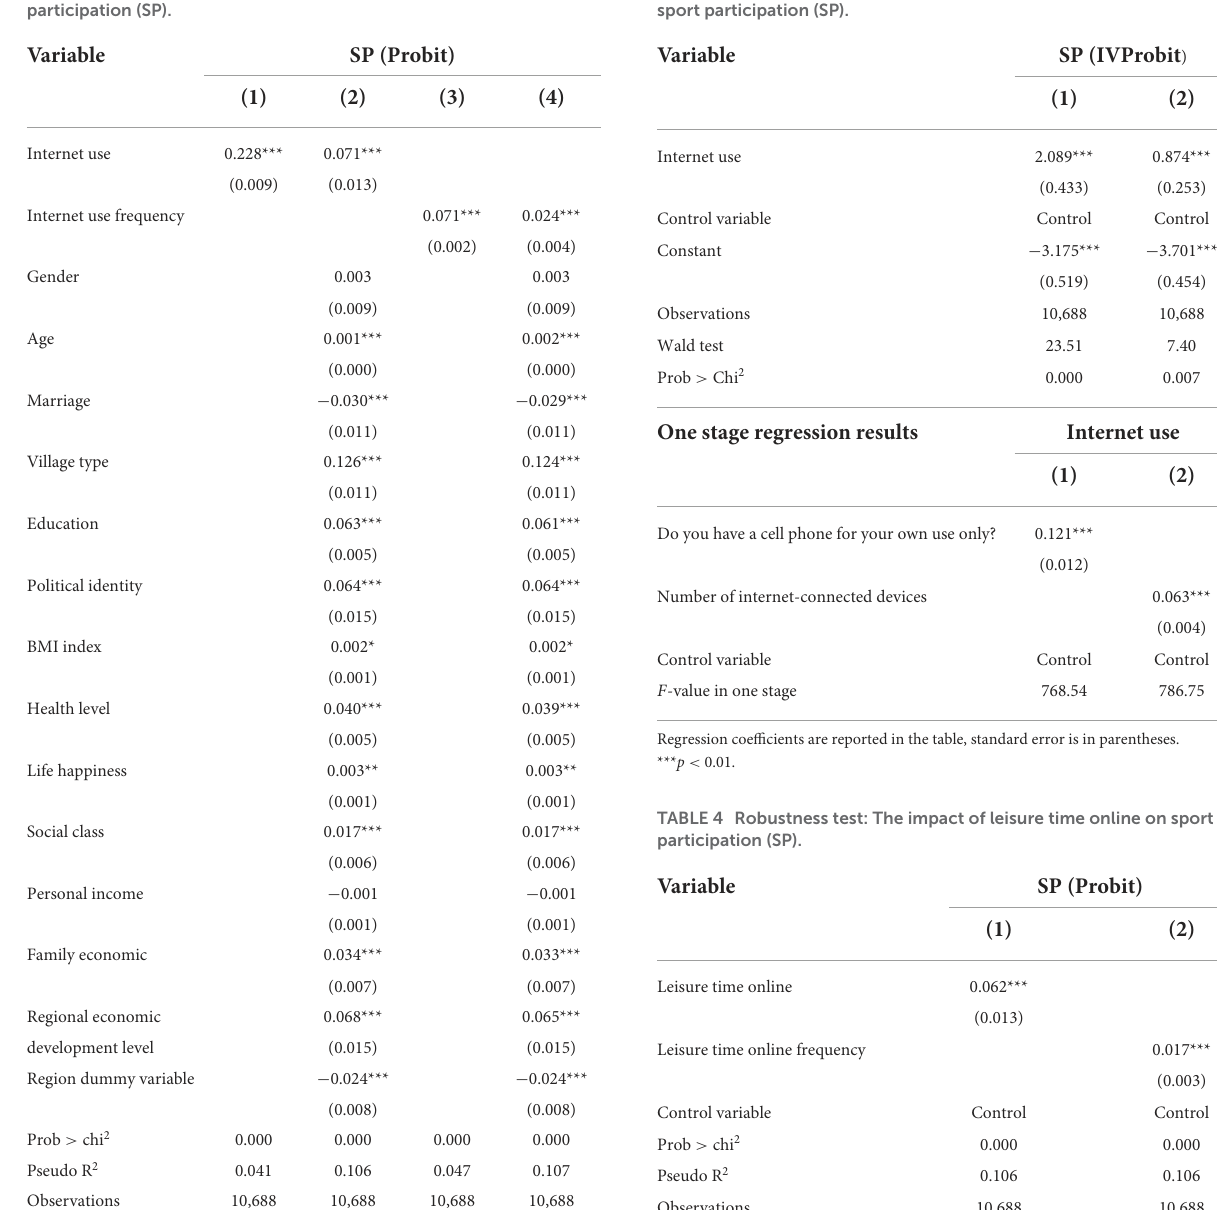
TABLE 2 Baseline regression: The impact of internet use on sport participation (SP).